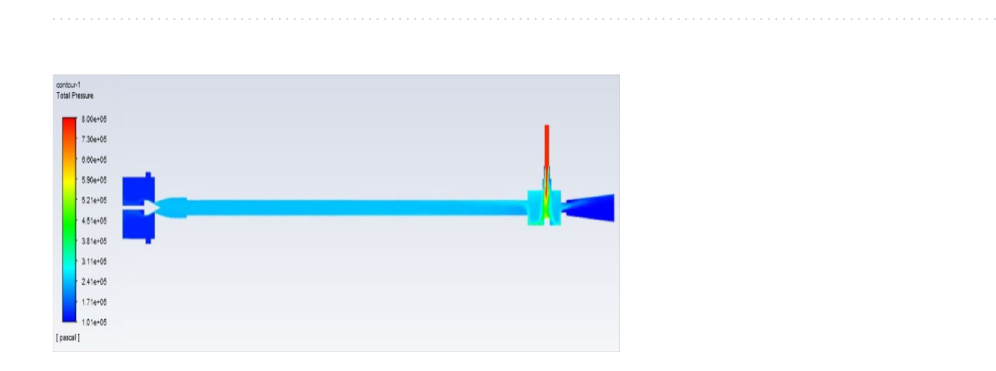
Figure 53. Pressure contours at 6 bar.